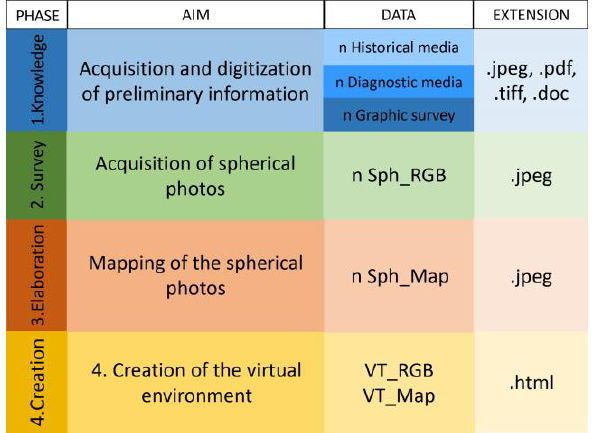
Figure 1. Methodology framework.